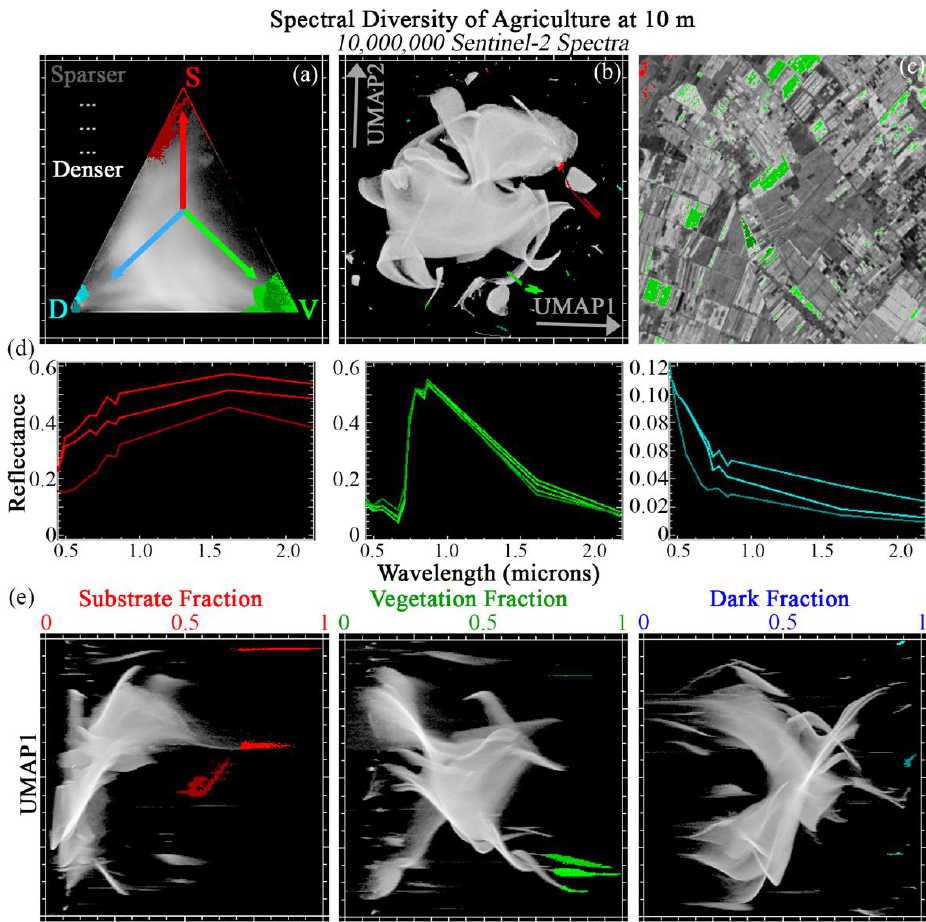
Figure 4. Joint characterization of agriculture. 10 × 1 megapixel Sentinel-2 tile subsets are selected from global agricultural hotpots and analyzed at full 10 m pixel resolution. These spectra fill out nearly the entire global SVD mixing space ( a ) and are well represented by a single global 3-endmember linear mixture model (99% of spectra with <5% RMSE). Manifold learning ( b , using UMAP) captures both subtle mixing continua and discrete clusters, but does not offer physical interpretability. Joint characterization ( e ) uses the physical meaning of the mixture fractions to contextualize the subtle statistical relationships captured by UMAP. Example regions of interest are identified from the joint space. Mean spectra for each region ( d ) illustrate similarities and differences among statistically distinct clusters. Statistically distinct clusters identified through joint characterization frequently show geographic coherence ( c ).